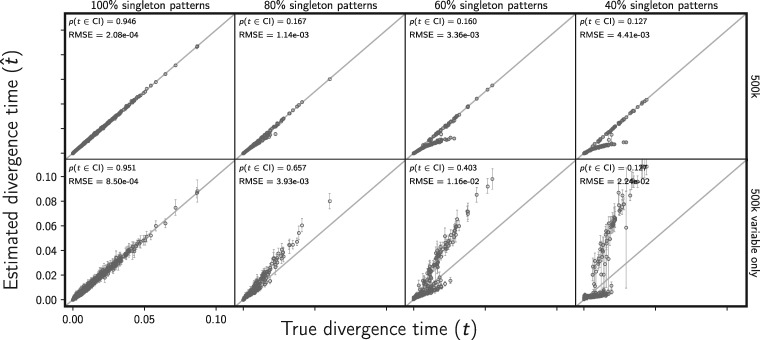
Assessing the effect of an acquisition bias against rare allele patterns on the accuracy and precision of divergence time estimates (in units of expected subsitutions per site). The columns, from left to right, show the results when each simulated 500,000-character data set has a probability of 100%, 80%, 60%, and 40% of sampling each simulated singleton pattern. For example, each character matrix analyzed in the far right column is missing approximately 60% of characters where all but one gene copy has the same allele. For comparison, the first column shows the results of the 500 data sets from Figure 2; the remaining columns show the results of 100 data sets. The rows show the results when (top) all sites and (bottom) only variable sites are analyzed. For each plot, the root mean square error (RMSE) and the proportion of estimates for which the 95% credible interval contained the true value—\documentclass[12pt]{minimal}
\usepackage{amsmath}
\usepackage{wasysym}
\usepackage{amsfonts}
\usepackage{amssymb}
\usepackage{amsbsy}
\usepackage{upgreek}
\usepackage{mathrsfs}
\setlength{\oddsidemargin}{-69pt}
\begin{document}
}{}$p({{t}}\in \textrm{CI})$\end{document}—is given. All simulated data sets had three pairs of populations. We generated the plot using matplotlib Version 2.0.0 (Hunter 2007)